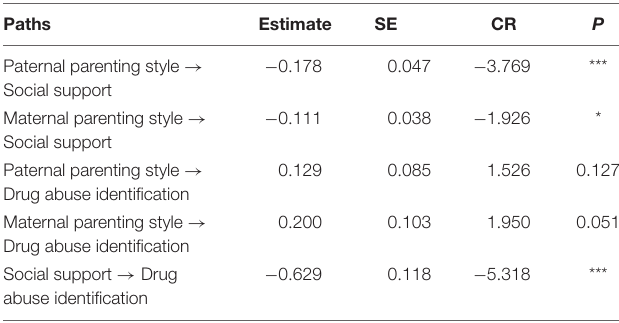
TABLE 3 | Path coefficients between maternal and paternal parenting styles, social support, and drug abuse identification. Paths Estimate SE CR